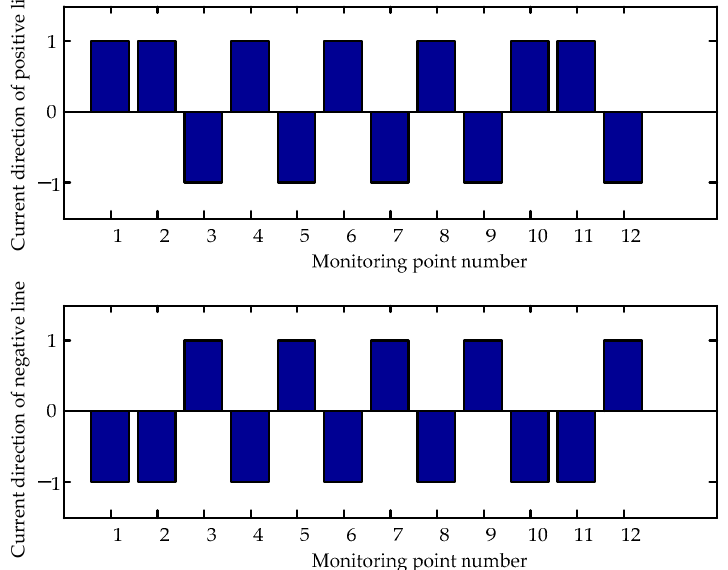
Figure 13. The current flow of monitoring point during pole ‐ to ‐ pole short ‐ circuit fault: ( a ) Positive line; ( b ) Negative line.